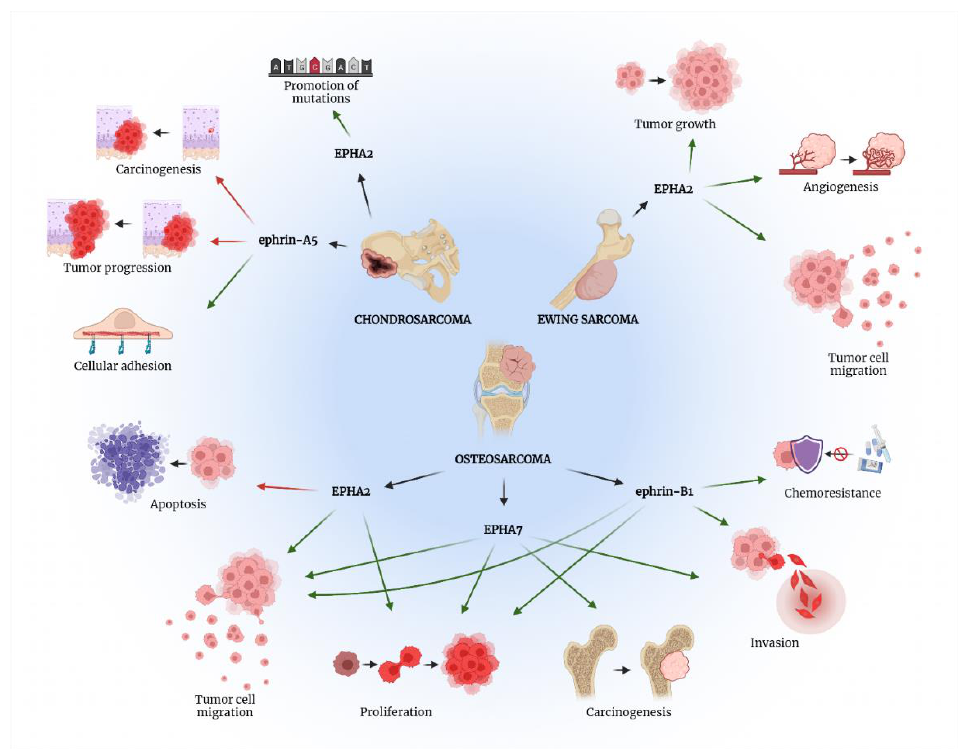
Figure 2. The role of EPH/ephrin axis in bone sarcomas’ pathogenesis. Green arrows present proce- dures promoted by the specific EPH/ephrin member, while red arrows show processes suppressed by the aforementioned molecules. Created with BioRender.com, accessed on 2 May